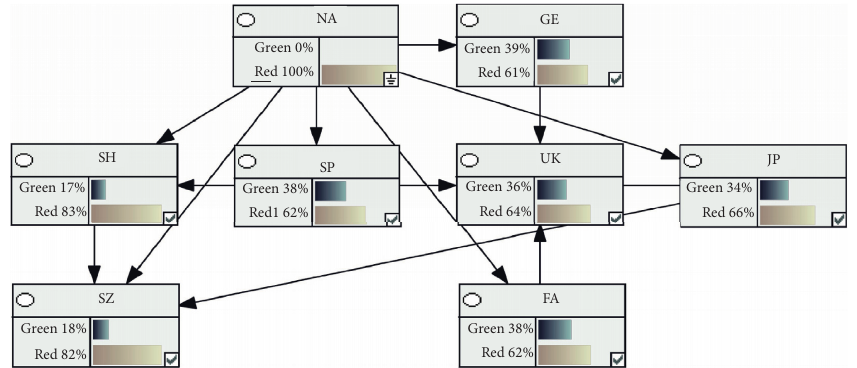
Figure 4: BN final state diagram (NA).